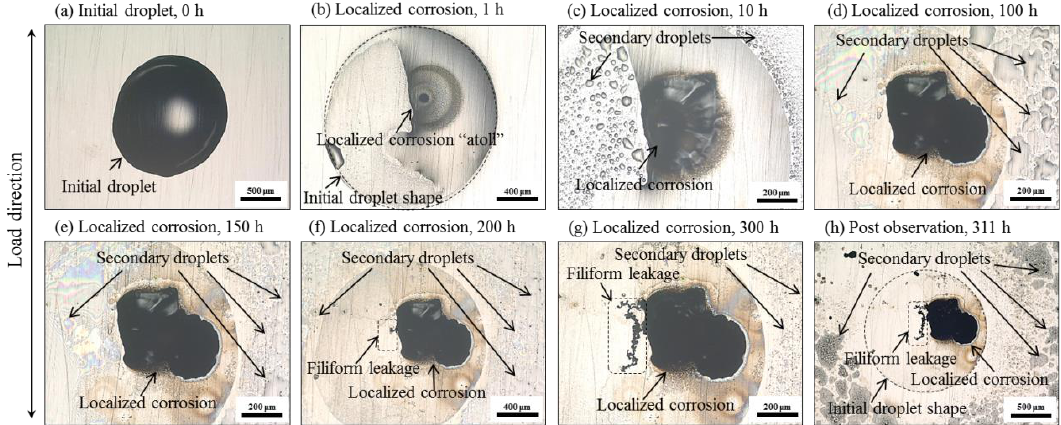
Figure 5. Localized corrosion in the u-bent specimen A with 311 h’ exposure to a single droplet of 1 μL neutral 1% NaCl solution in 99% relative humidity at room temperature: (a–g) in-situ observation; (h) post-observation.